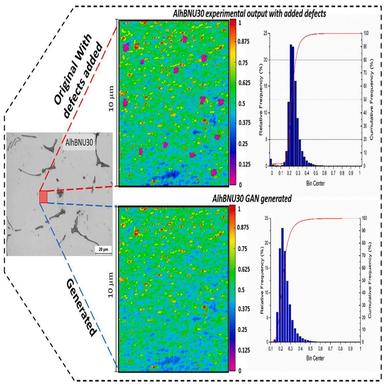
Al-hBNU30 normalized elastic modulus mapping graphical representation and comparison of frequency and cumulative distribution of original recording (Top) and GANs Re-generated datasets (Bottom).